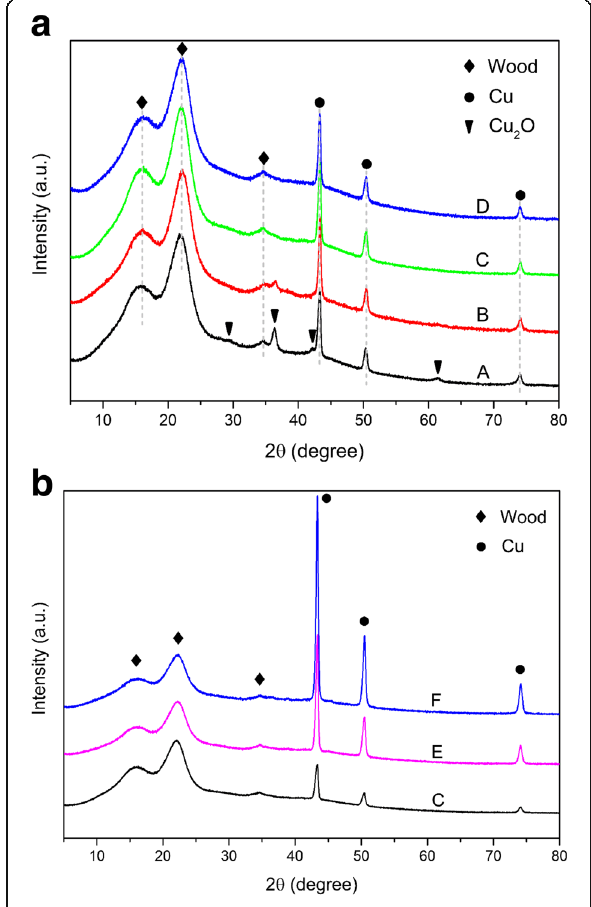
Fig. 3 XRD patterns of samples in a groups A – D, b groups C, E, and